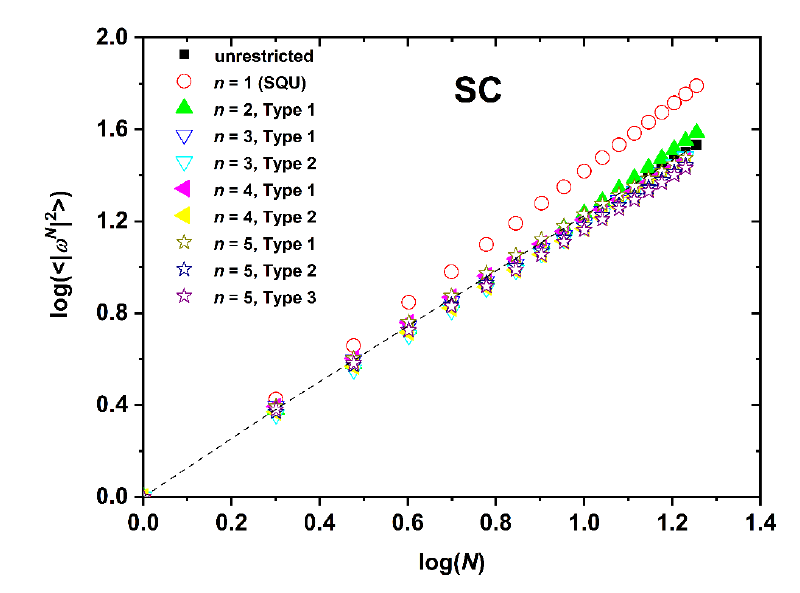
(cid:12) (cid:12) 2 (cid:105) (cid:12) (cid:12) , as a function of the logarithm (cid:12) ω N (cid:12)